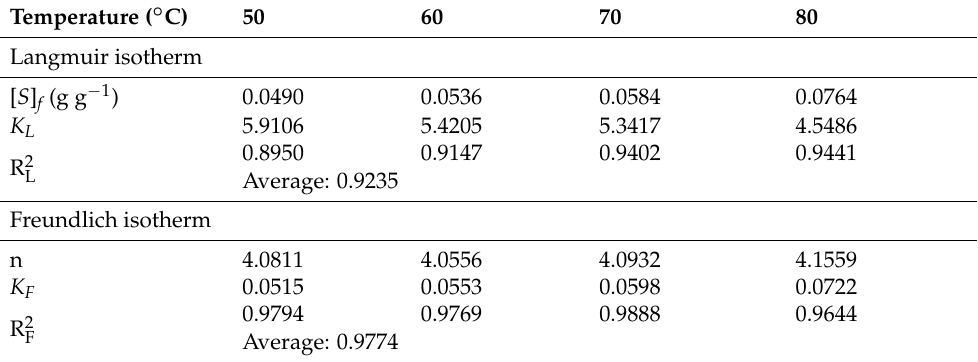
Figure 7. Isotherms of dyeing of raw ramie yarn with Reactive Blue 194 in palm oil medium: ( a ) Langmuir and ( b ) Freundlich, and in water medium: ( c ) Langmuir and ( d ) Freundlich. Table 3. Parameters of Langmuir and Freundlich isotherms of dyeing of raw ramie yarn with Reactive Blue 194 in palm oil medium .